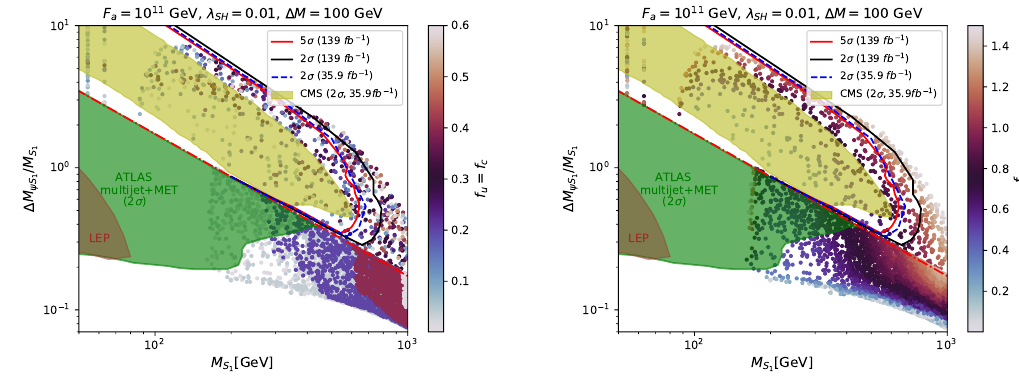
Figure 10. The solid red line is the 5 σ discovery contour, and any point inside the red line has a statistical significance > 5 σ at 14 TeV LHC for an integrated luminosity 139 fb − 1 . The dashed red line corresponds to ∆ M = M = M . Below the dashed red line, we can not probe Ψ S 1 Ψ − M S 1 top with the boosted tops plus missing energy signal, as we can not get any on-shell top from the decay of Ψ . The solid black and blue dashed lines are the exclusion contour ( 2 σ ) of our analysis for an integrated luminosity of 139 fb − 1 and 35.9 fb − 1 , respectively. The exclusion region ( 2 σ ) from the existing LEP, ATLAS (multijet + MET), and CMS ( t ¯ t + MET) analysis are shown by brown, green, and olive color,